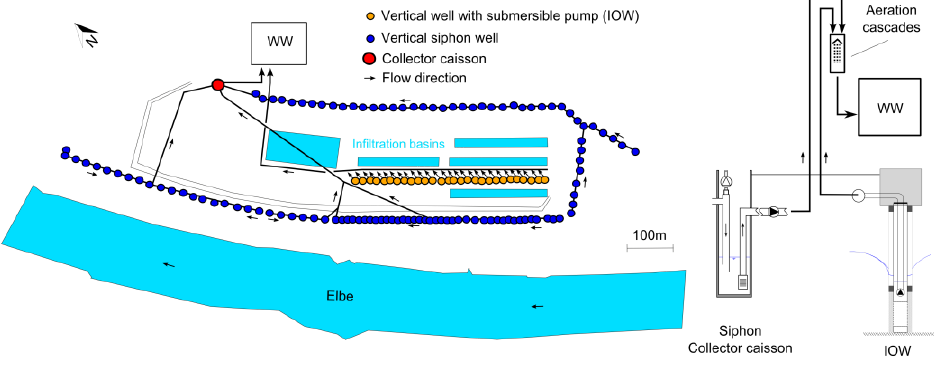
Figure 4. Map of WW Dresden-Hosterwitz with approximate well locations. Table 1. Well design parameters WW Dresden-Hosterwitz, Germany.